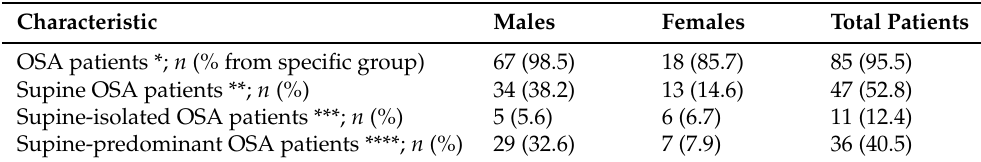
Table 2. Characterictics of OSA